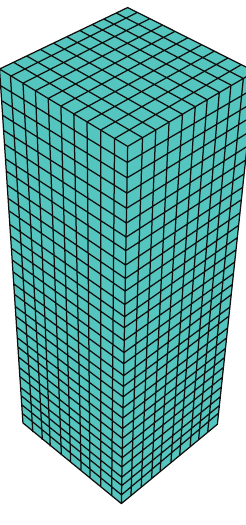
Figure 3: Specimen model.